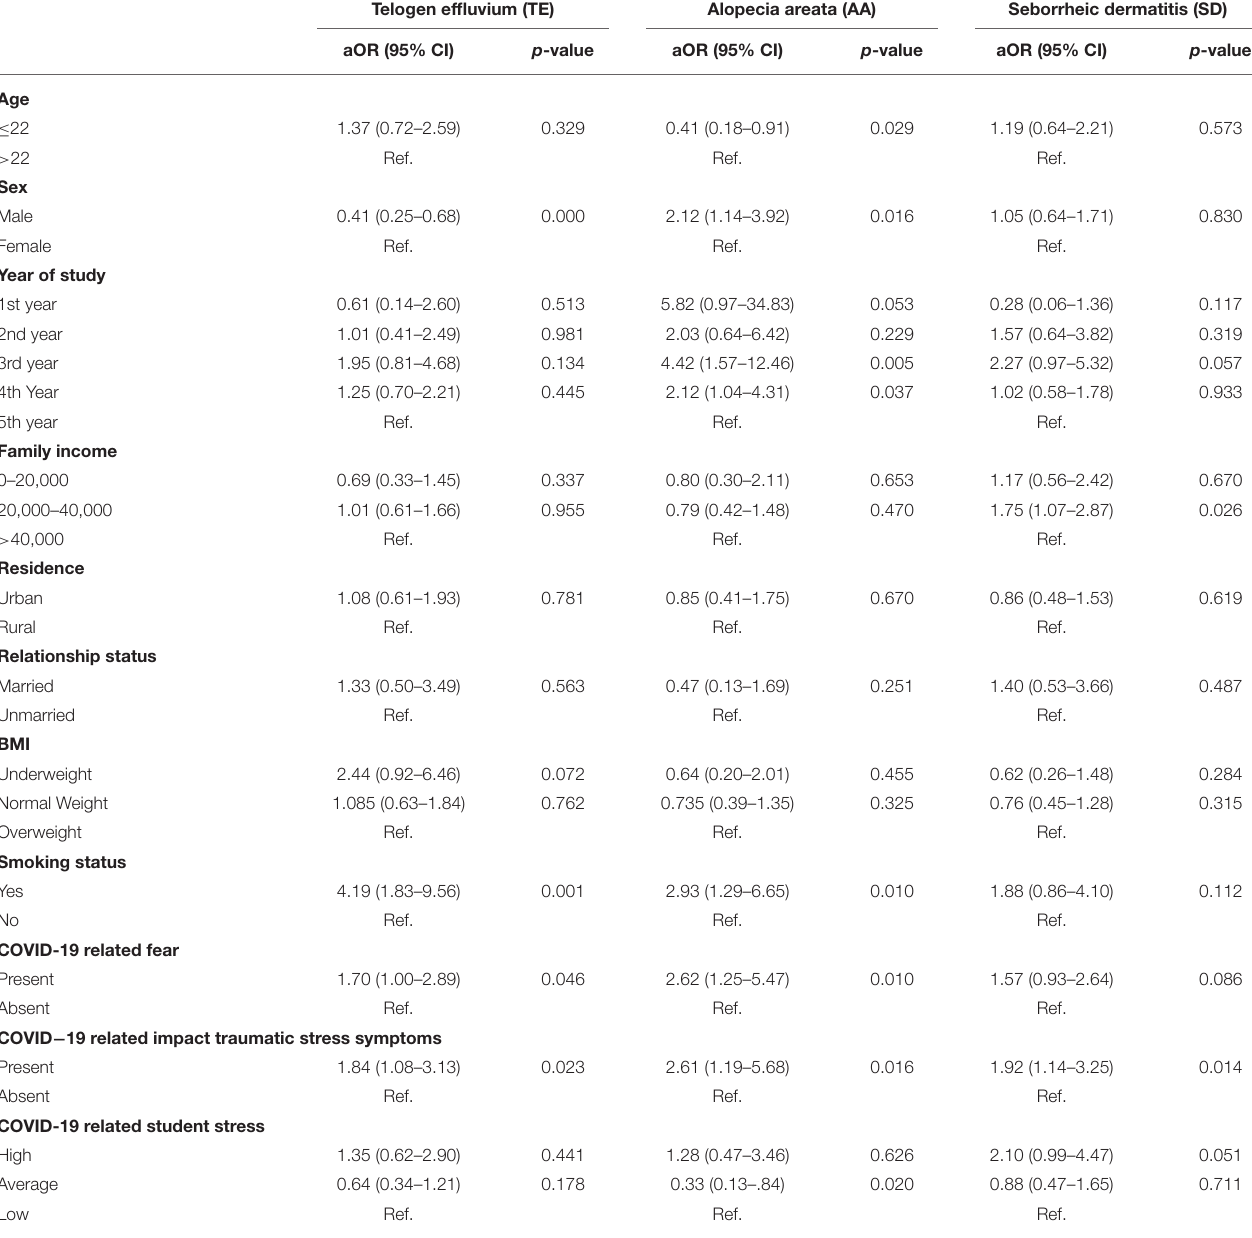
TABLE 3 | Multiple logistic regression model for the variables associated with TE, AA, and SD ( n = 404). Telogen effluvium (TE) Alopecia areata